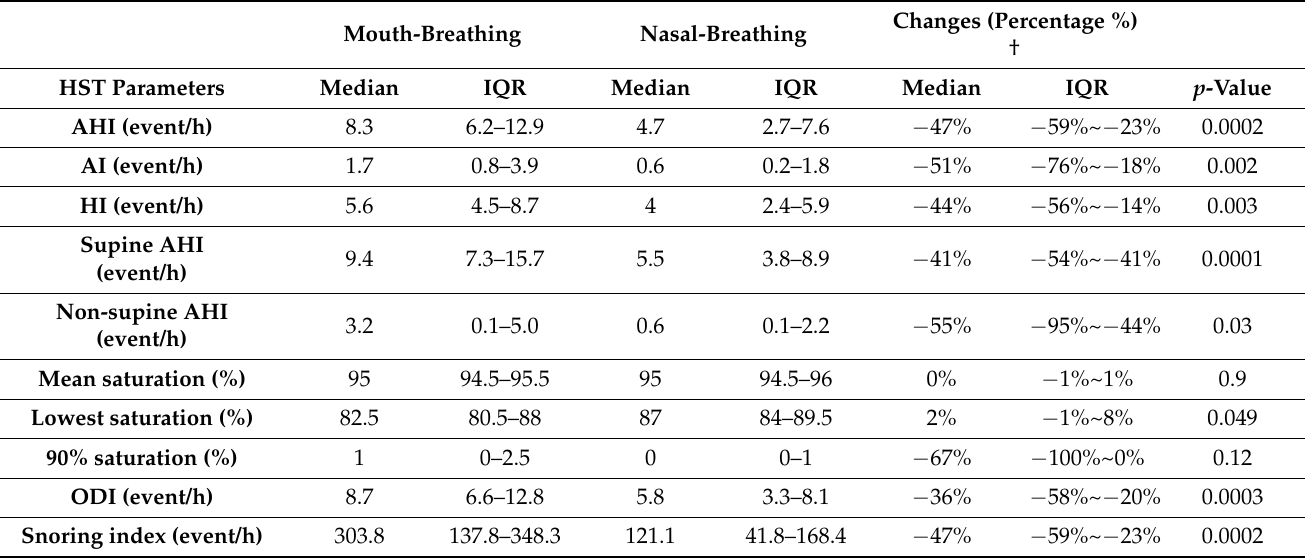
Figure 2. Box graph of apnea/hypopnea index (AHI), apnea index (AI), and hypopnea index (HI) before and after mouth-taping . (The green and red dots represent outliners of each parameter)